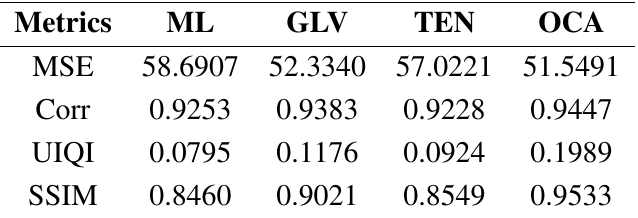
Table 2. Comparison for SFF methods with various